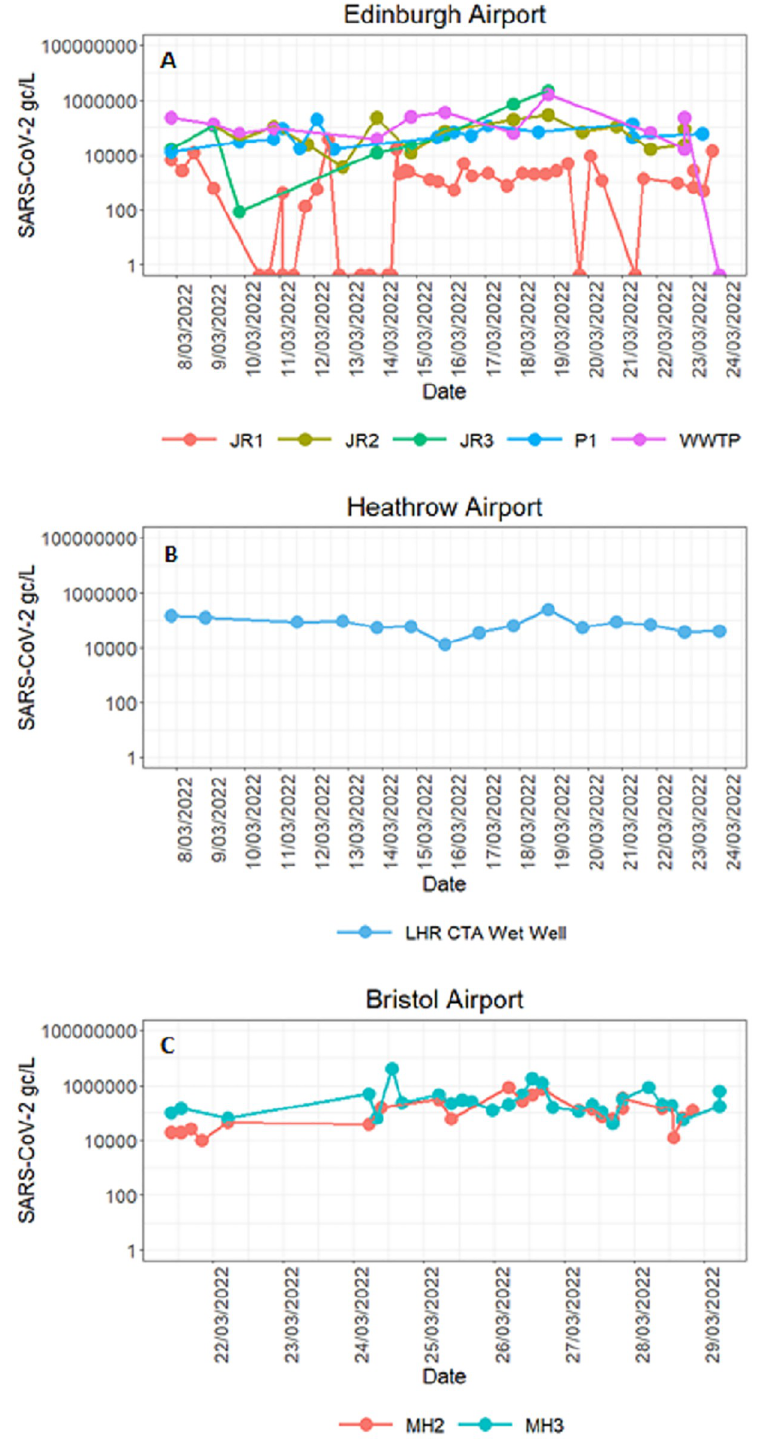
Fig 3. SARS-CoV-2 RNA concentrations in genome copies (gc)/l at (A) Edinburgh, (B) Heathrow and (C) Bristol airports.